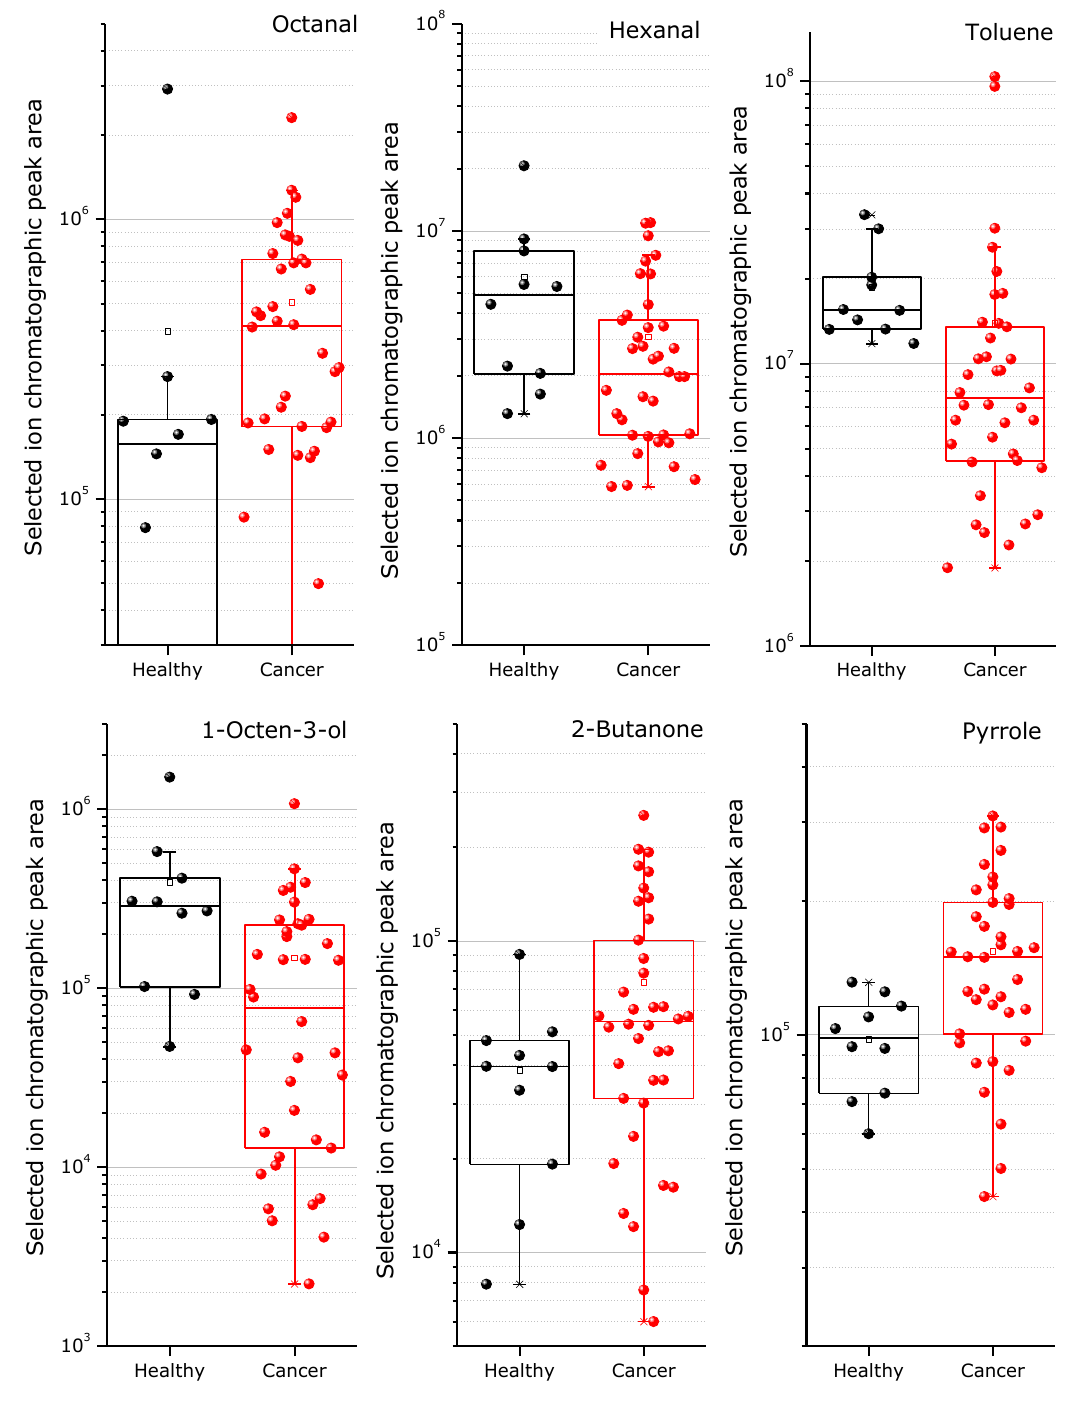
Figure 3. Distribution charts representing the variance in healthy and cancerous sample groups for six common volatile metabolites released from blood plasma during drying by He gas, subsequent adsorption in a Tenax GR filled tube and TD-GC-MS analysis (y-scale showing peak area in chromatogram, points represent individual measured samples, box borders, respectively, 25 and 75% samples